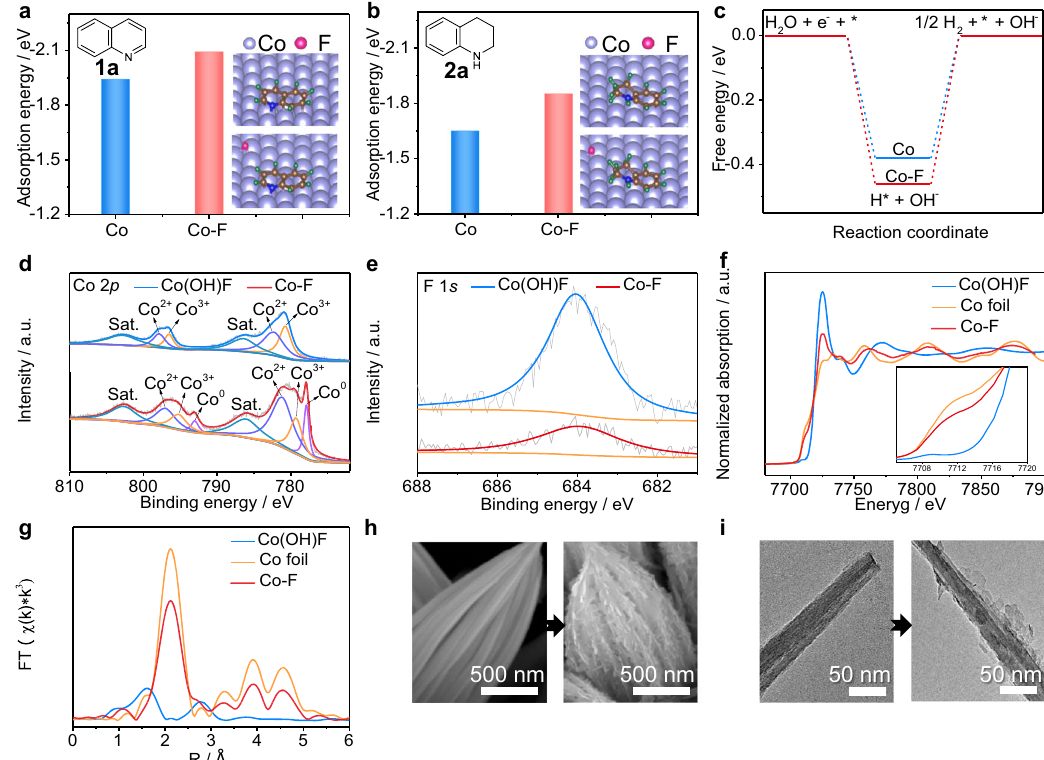
Fig. 1 | Synthesis of Co-F NWs by electroreduction of Co(OH)F NWs. a , b Comparisonsof E ads of 1a and 2a onpureCoandCo-F,respectively(insert:the stableadsorptionmodesof 1a and 2a ). c Thecalculated Δ G H* overpureCoandCo- F. d Co 2 p XPS spectra and e F 1 s XPS spectra of the Co(OH)F and Co-F catalysts.